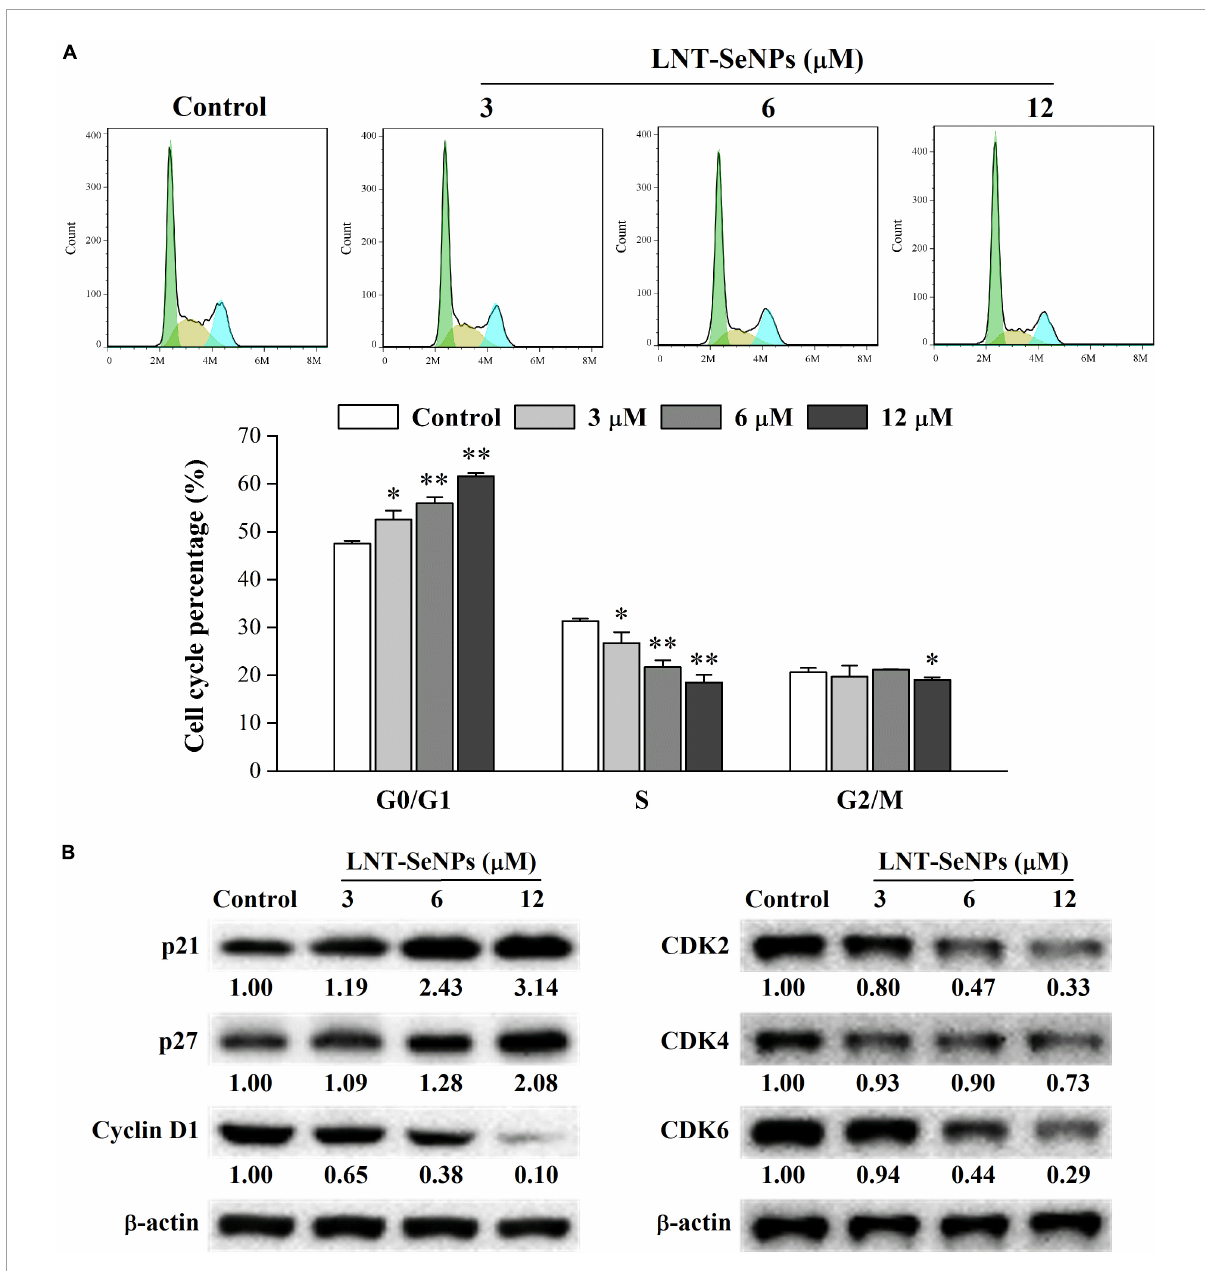
FIGURE7 Effects of LNT-SeNPs treatment (3, 6, and 12 µ M) on the cell cycle progression in HCT-116 cells. The cell cycle distribution of HCT-116 cells was analyzed by the PI staining method (A) ; the protein expression levels of p21, p27, cyclin D1, CDK2, CDK4, and CDK6 were detected by western blot (B) . Data were shown as mean values ± SD ( n = 3). ∗ p < 0.05 and ∗∗ p < 0.01 compared to the control